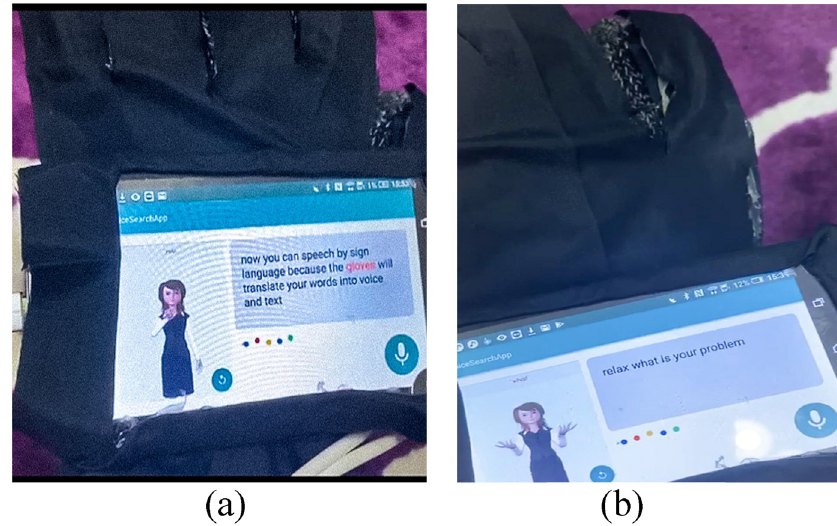
Figure 9: Samples of sign language gestures with the corresponding text displayed on the LCD ( a ) and ( b )